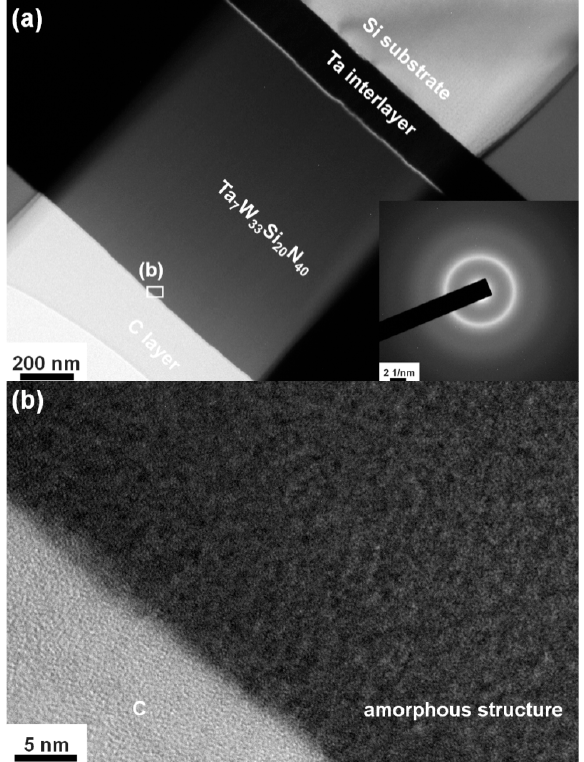
Figure 5. ( a ) XTEM image and SAED pattern and ( b ) HRTEM image of the Ta 7 W 33 Si 20 N 40